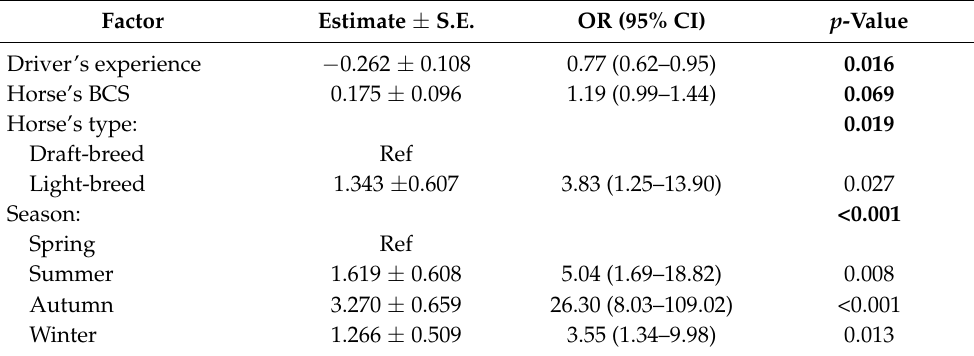
Table 12. Injured horses—final multiple regression model for the dummy dependent variable of presence/absence of injured horses at arrival at the slaughterhouse. Data are presented as estimates and standard errors (S.E.) of the effect, odds ratio (OR), confidence interval (95% CI), and p -value. Bold p -values refer to the statistical significance or trend towards the significance of the predictive variable in the model; the significance of a category against the reference is reported in regular font. Factor Estimate ± S.E.